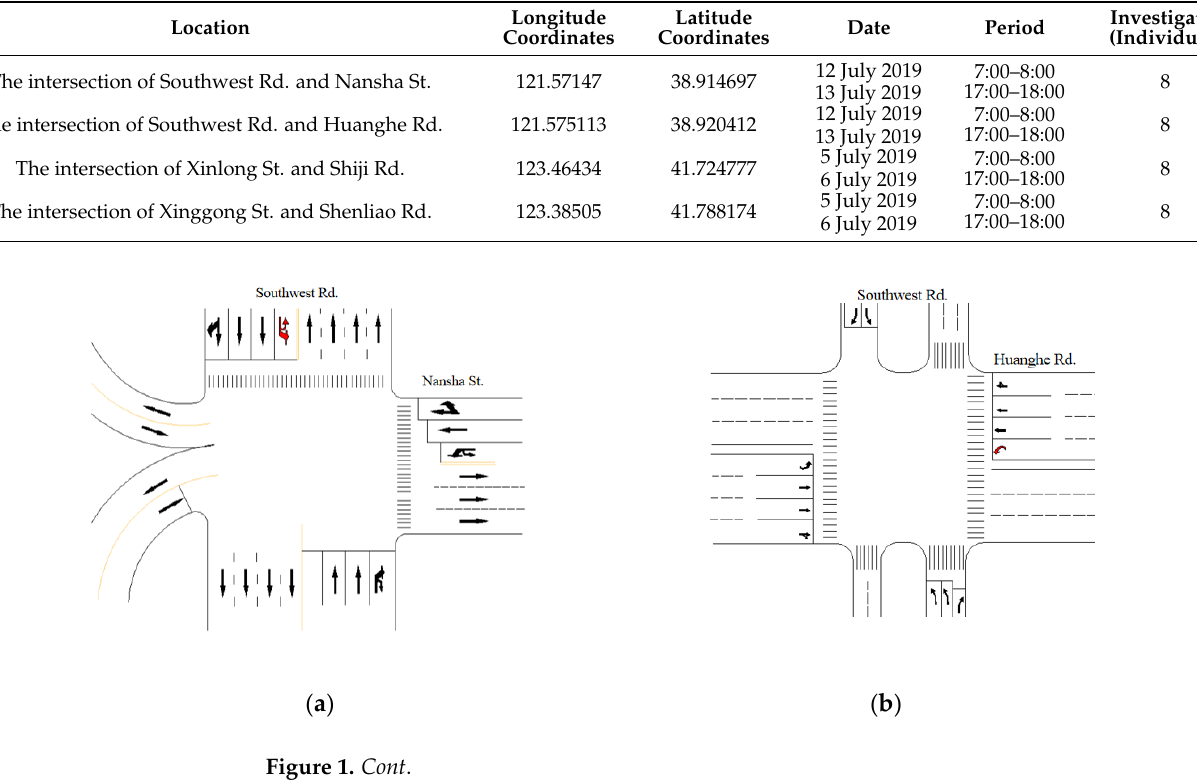
Table 1. Survey plan.